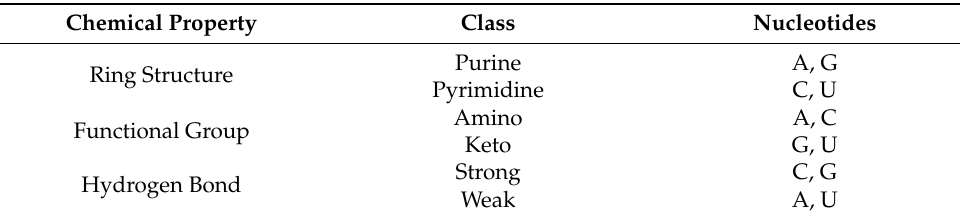
Table 2. Chemical structure of each